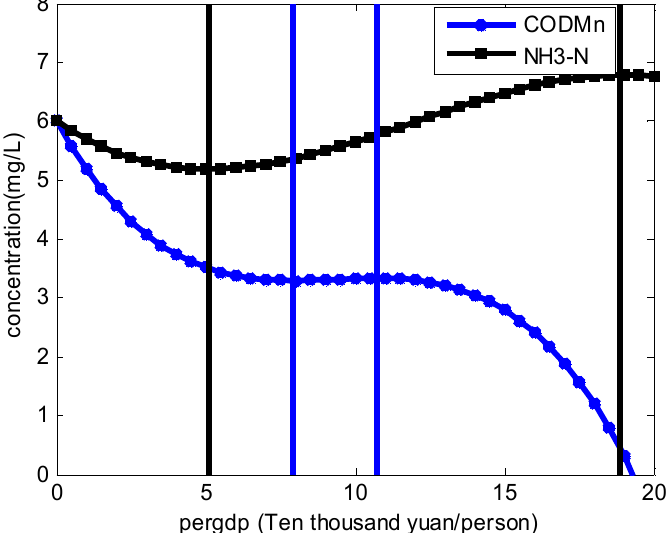
Figure 3. Environmental Kuznets Curve (EKC) of COD Mn and NH 3 -N. Notes: Blue curve denotes COD Mn and the black denotes NH 3 -N. Overall concentration of NH 3 -N is actually lower than that of COD Mn , the curve of it is adjusted upwards for the aesthetics of the figure.